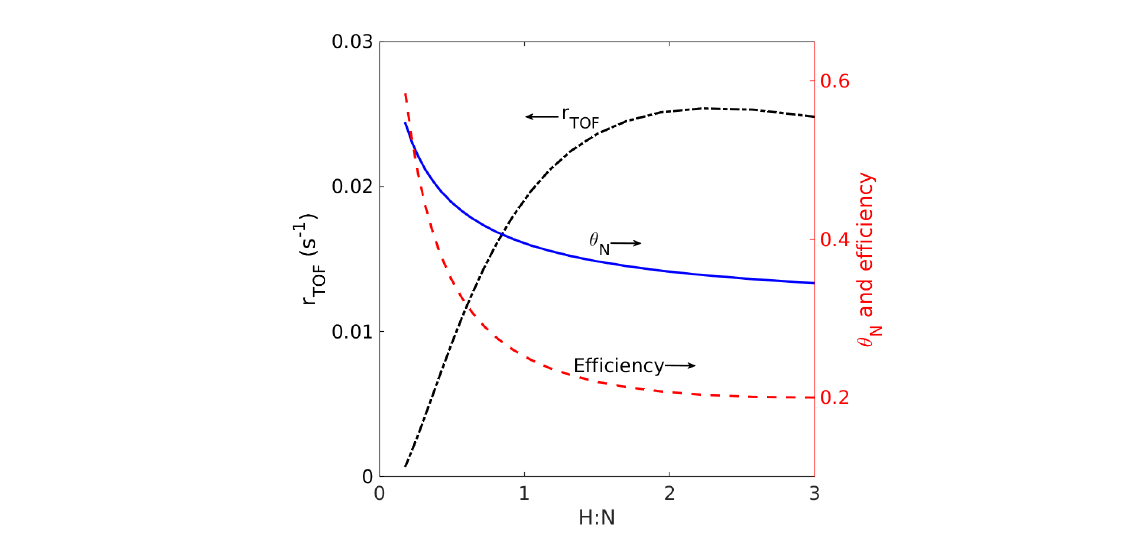
Figure 5. Change of intrinsic synthesis rate (2 r 2 ), atomic adsorbed nitrogen and efficiency with H:N for 30 ppm water in a gas mixture with y NH